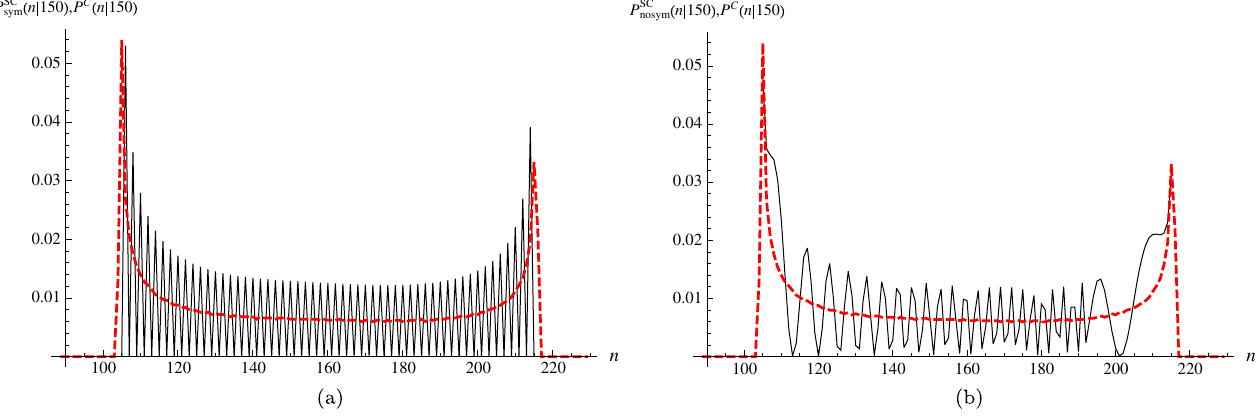
FIG. 6. Contributions to the interference pattern in P SC ð n j m Þ . Panel (a) includes only interferences between symmetry-related trajectories, while (b) includes only interferences between nonsymmetry-related